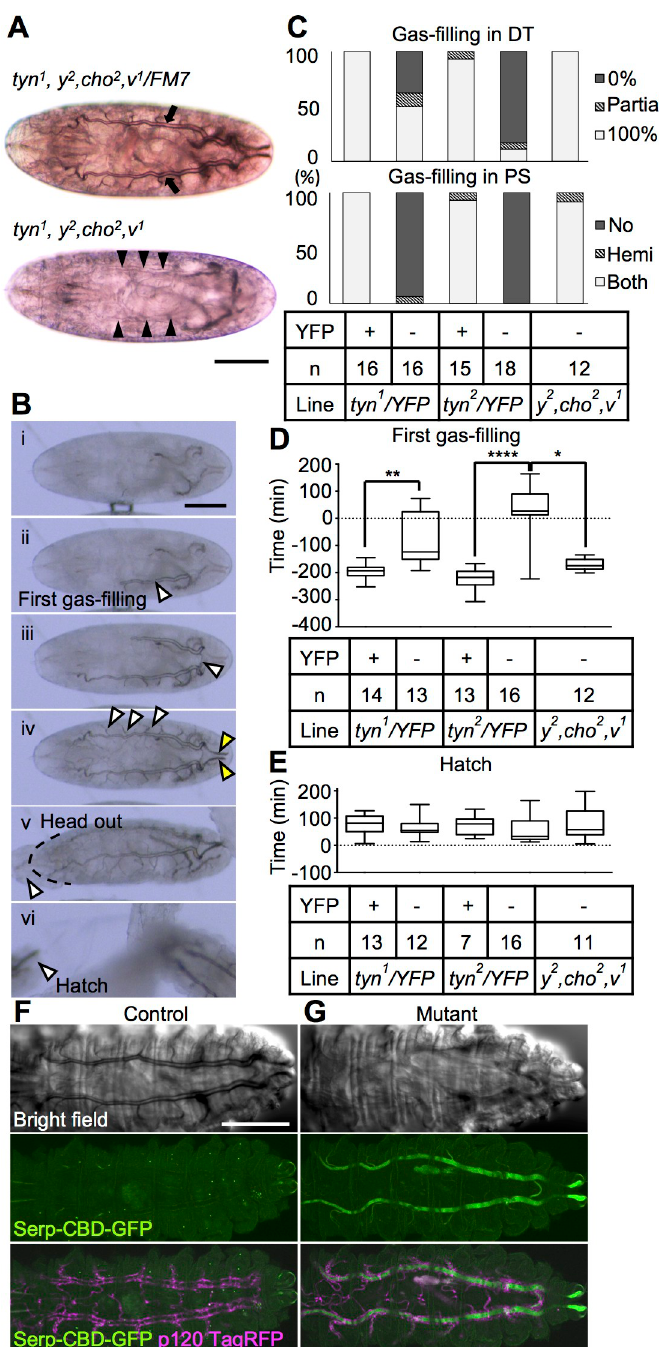
Fig 6. Delayed and partial gas-filling, and protein clearance failure in tyn mutants. (A) Tracheal tubules in a tyn 1 sibling control embryo were filled with gas and bordered by a thick black line (upper panel, arrows). In the tyn 1 mutant, the trachea had translucent borders and lacked gas (bottom panel, arrowheads). (B) The normal gas-filling process observed in a tyn 1 sibling control: (i) tracheal tube before liquid-gas transition, (ii) first gas-filling, (iii) extension to the contralateral side through posterior anastomosis (arrowhead), (iv) subsequent propagation to the branches (white arrowheads) and posterior spiracles (yellow arrowheads), (v) extrusion of the head from the vitelline membrane, (vi) hatching. (C) The degree of gas-filling was classified into three levels for each of the two parts, dorsal trunk (DT, upper) and posterior spiracles (PS, bottom), for each of five genotypes: tyn 1 sibling control, tyn 1 mutant, tyn 2 sibling control, tyn 2 mutant, and no-mutation control (left to right). The YFP signal indicated the presence of